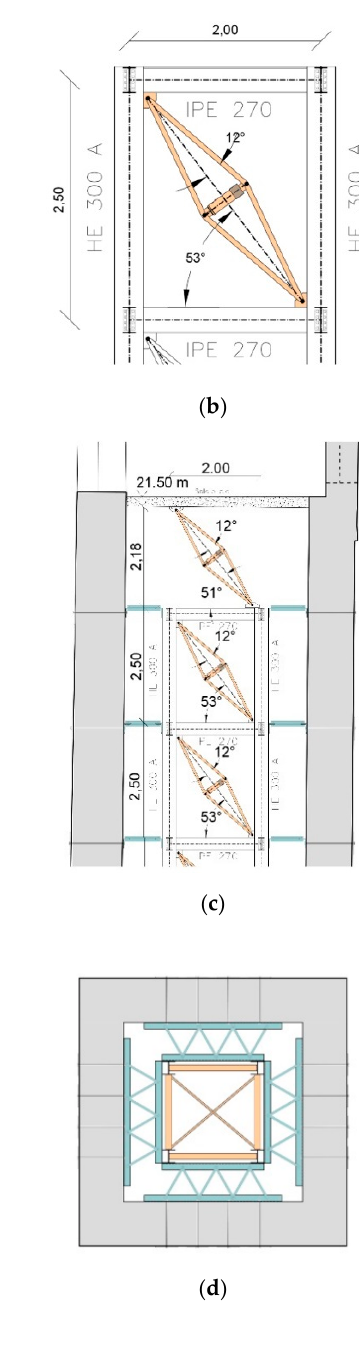
Figure 17. Scheme of the inner dissipative tower: ( a ) section in the XZ plan; ( b ) detail of the scissor-jack-damper configuration within the inner steel tower; ( c ) XZ plan view; and ( d ) in-plan view (XY) of the connections between the inner and outer tower.